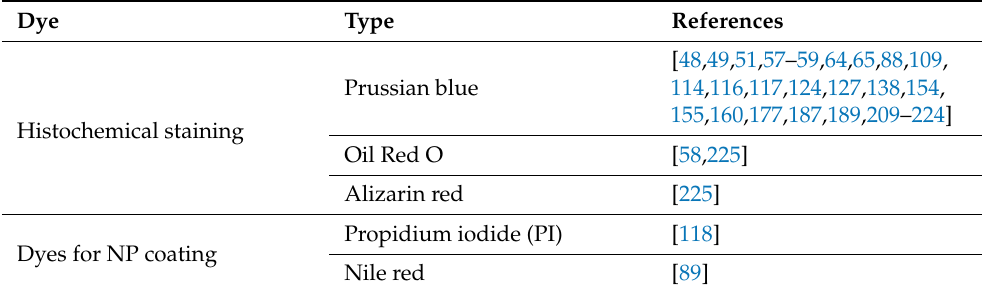
Table 4. Dyes used for ex vivo quantification of NP uptake. Dyes can react with elements characteriz- ing the NPs or can be applied for NP coating.